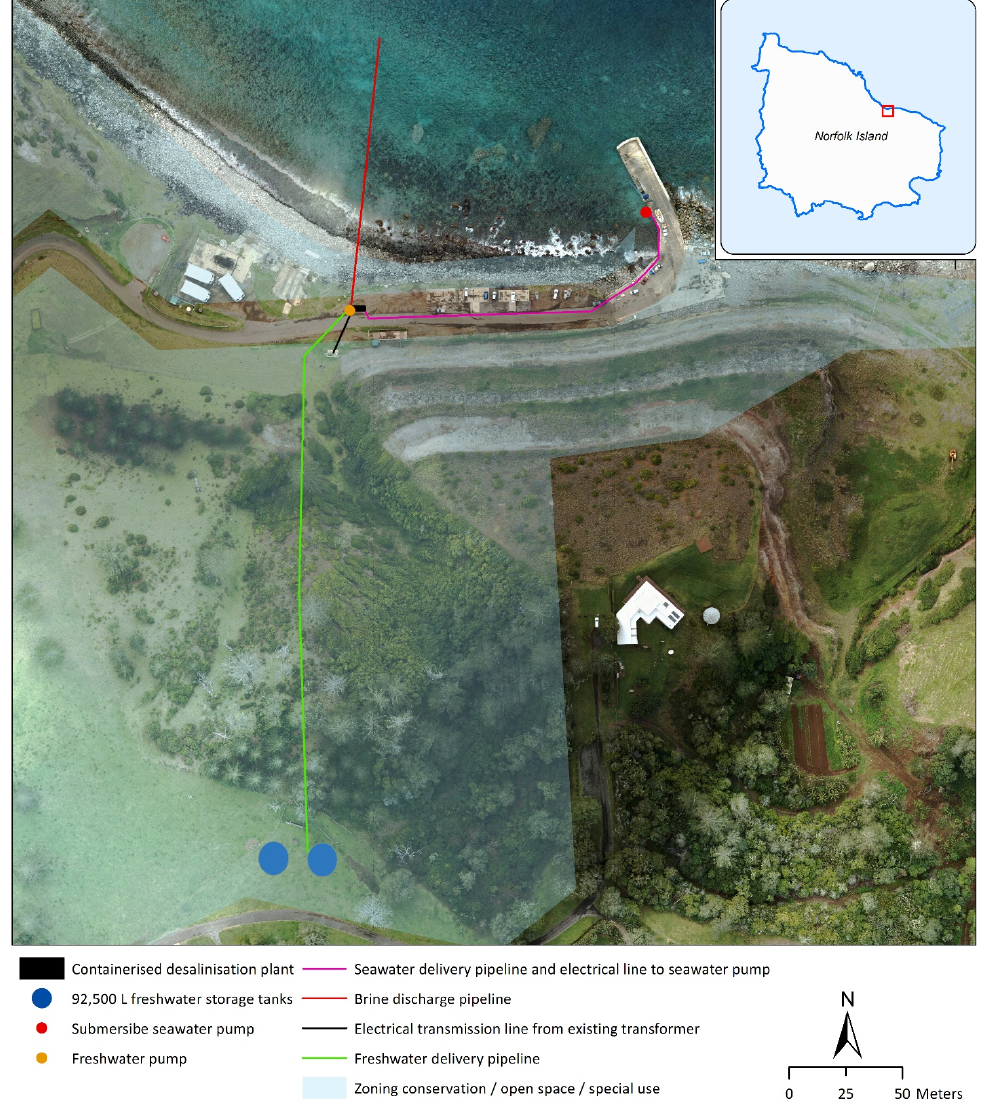
Figure 1. Potential desalination infrastructure configuration at Cascade Pier, Norfolk Island.